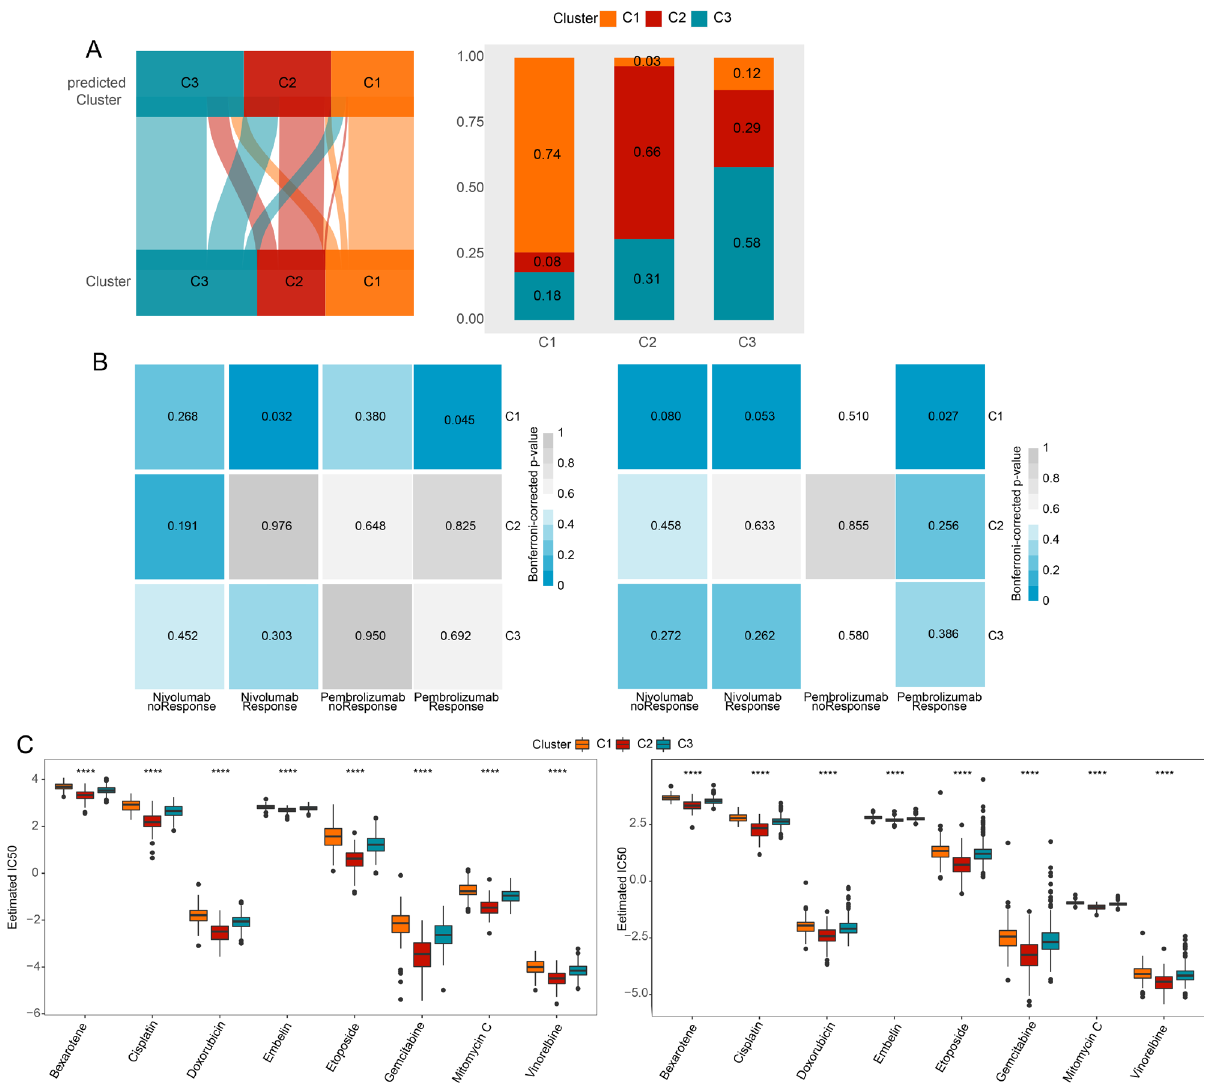
Figure 7 – Development of a classifier and comparison of immune and targeted therapy among the 3 clusters. (A) Left: Classification consistency between the 60 genes-classifier and the original prediction based on ConsensusClusterPlus. Right: The distribution between 60 genes-classifier and original prediction based on ConsensusClusterPlus. (B) Sensitivity analysis for responses to nivolumab and pembrolizumab in (left) TCGA and (right) GSEdat databases. (C) Sensitivity of IC50 for targeted drugs in the 3 clusters in (left) TCGA and (right) GSEdat databases. **** p <